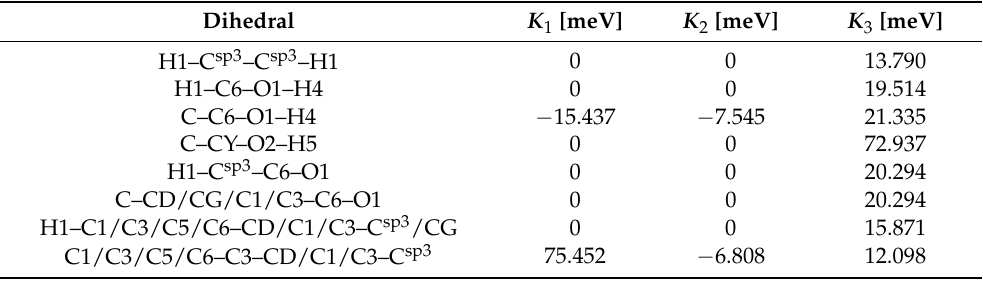
(cid:17) 12 (cid:16) σ (cid:17) 6 (cid:16) σ ij ij − ] r ij r ij